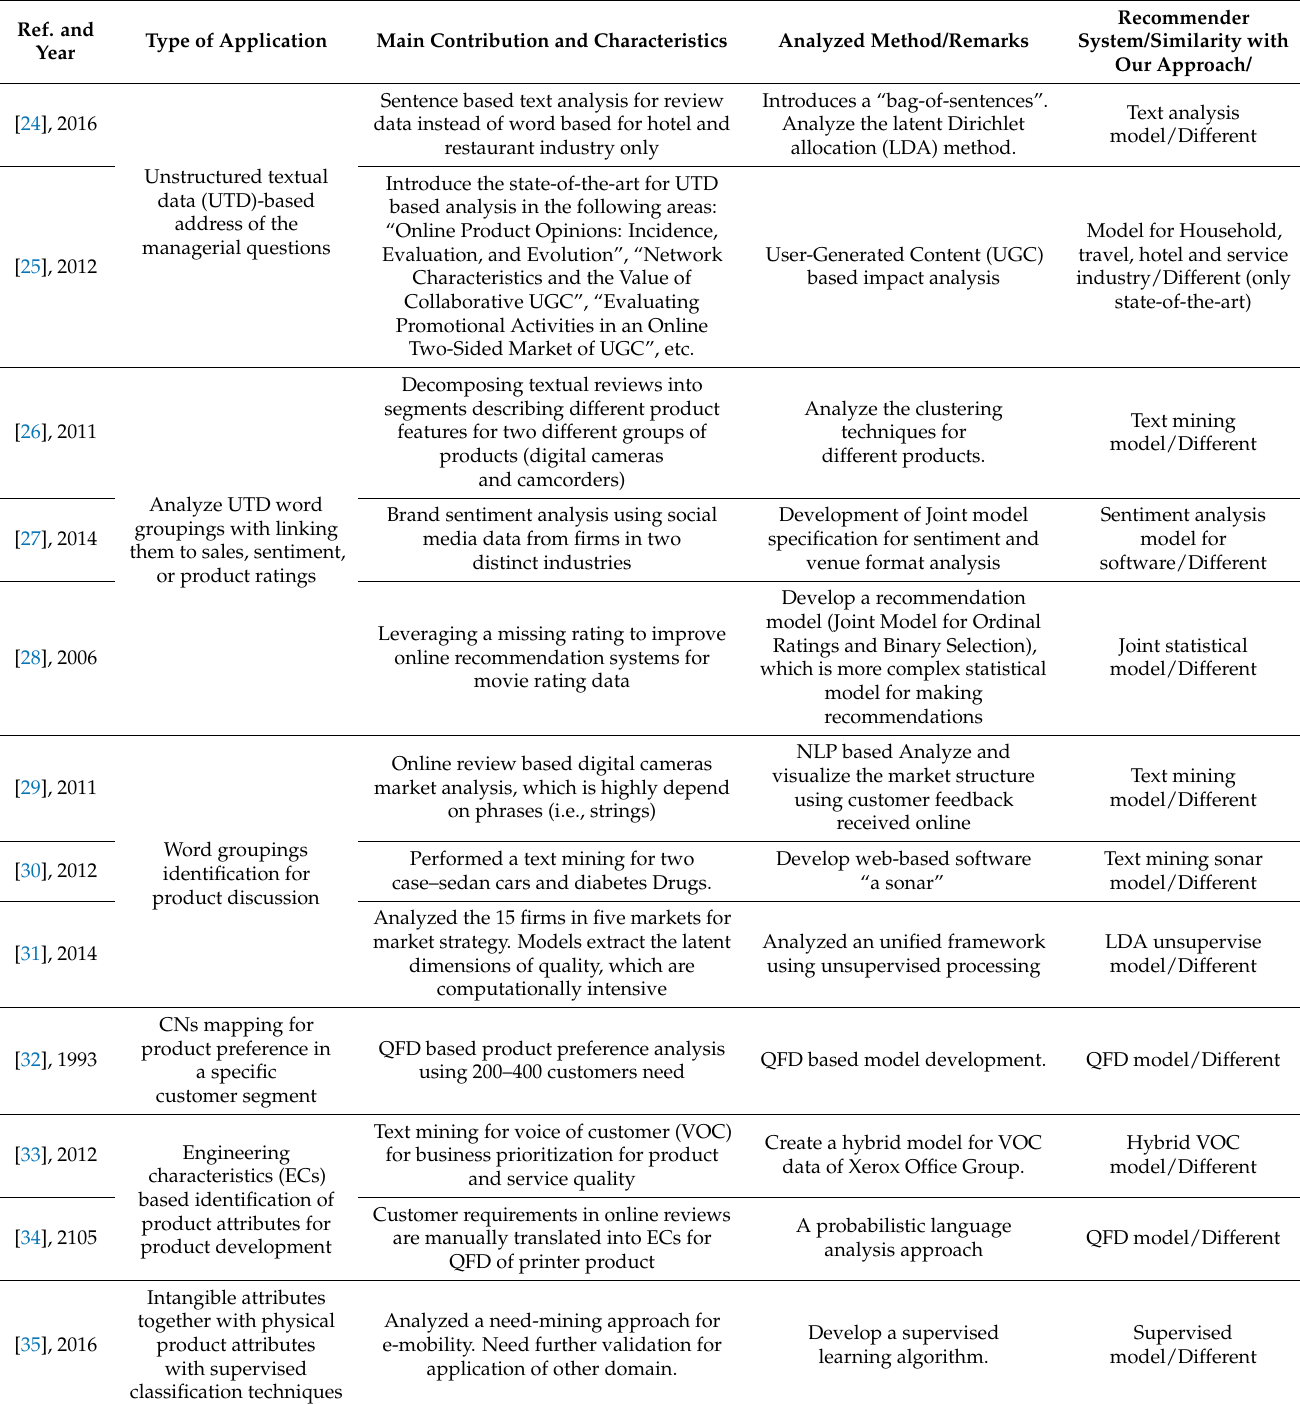
Table 3. Summary of the Customer created information (CCI)-based text analysis in marketing and product development